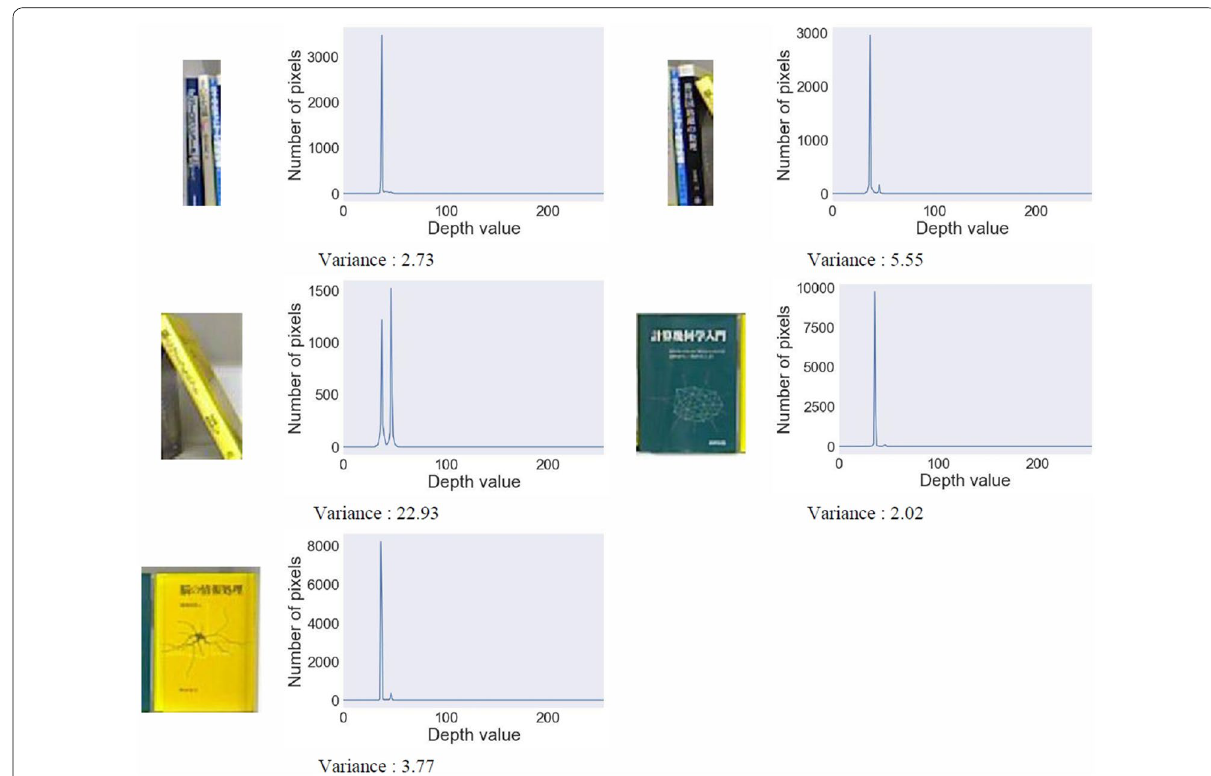
Fig. 26 Histogram and variance of depth